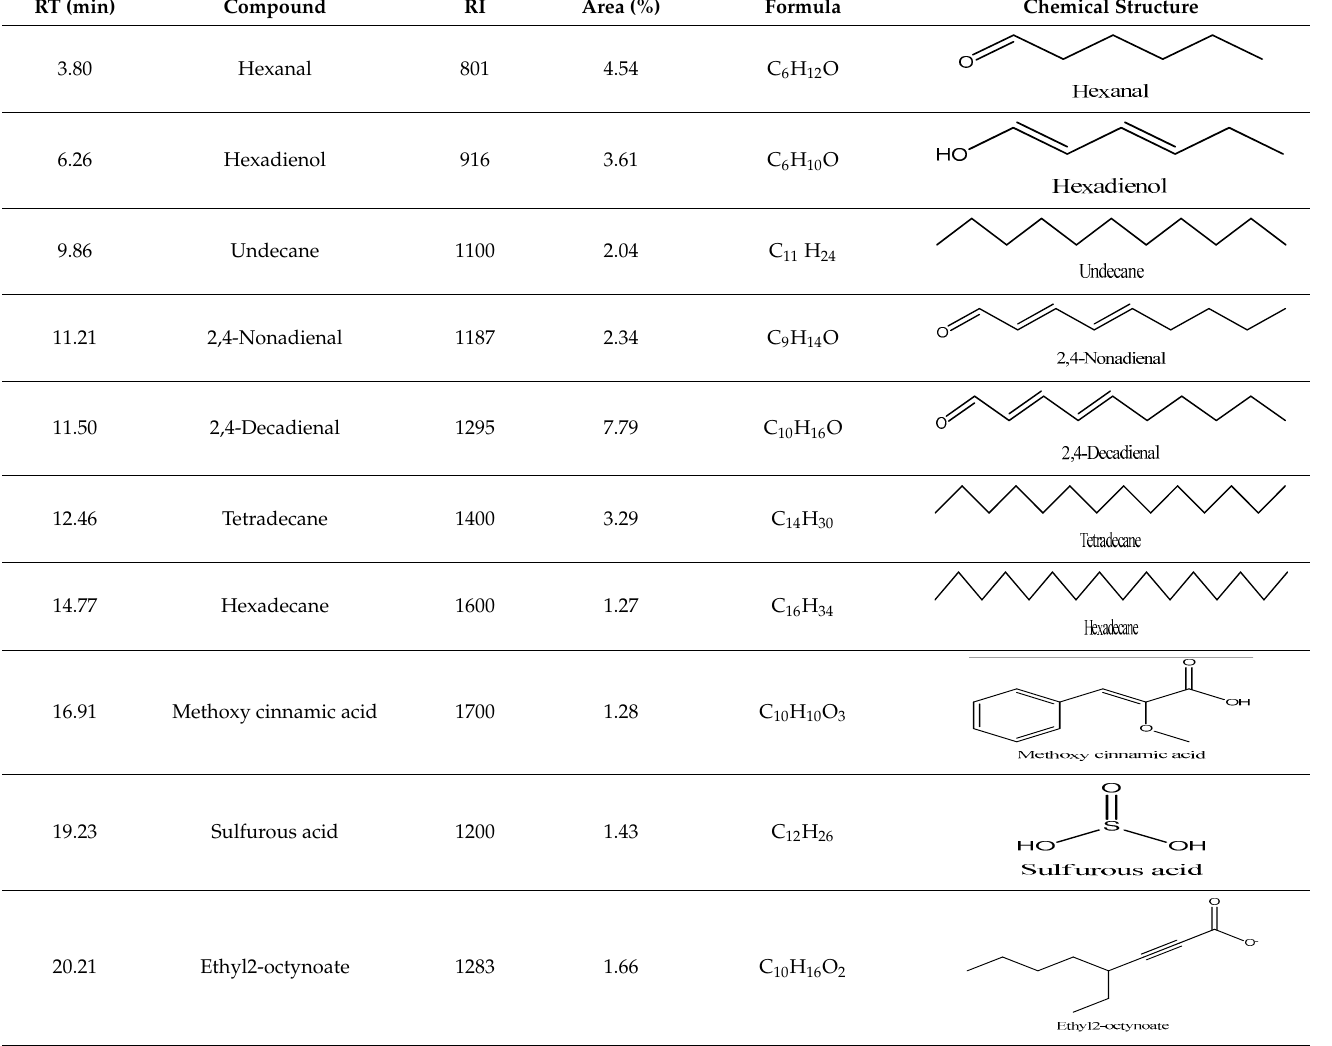
Figure 5. Chromatogram of chemicals identified in C. colocynthis seed extract. Table 1. Chemical compounds identified in C. colocynthis seed extract.